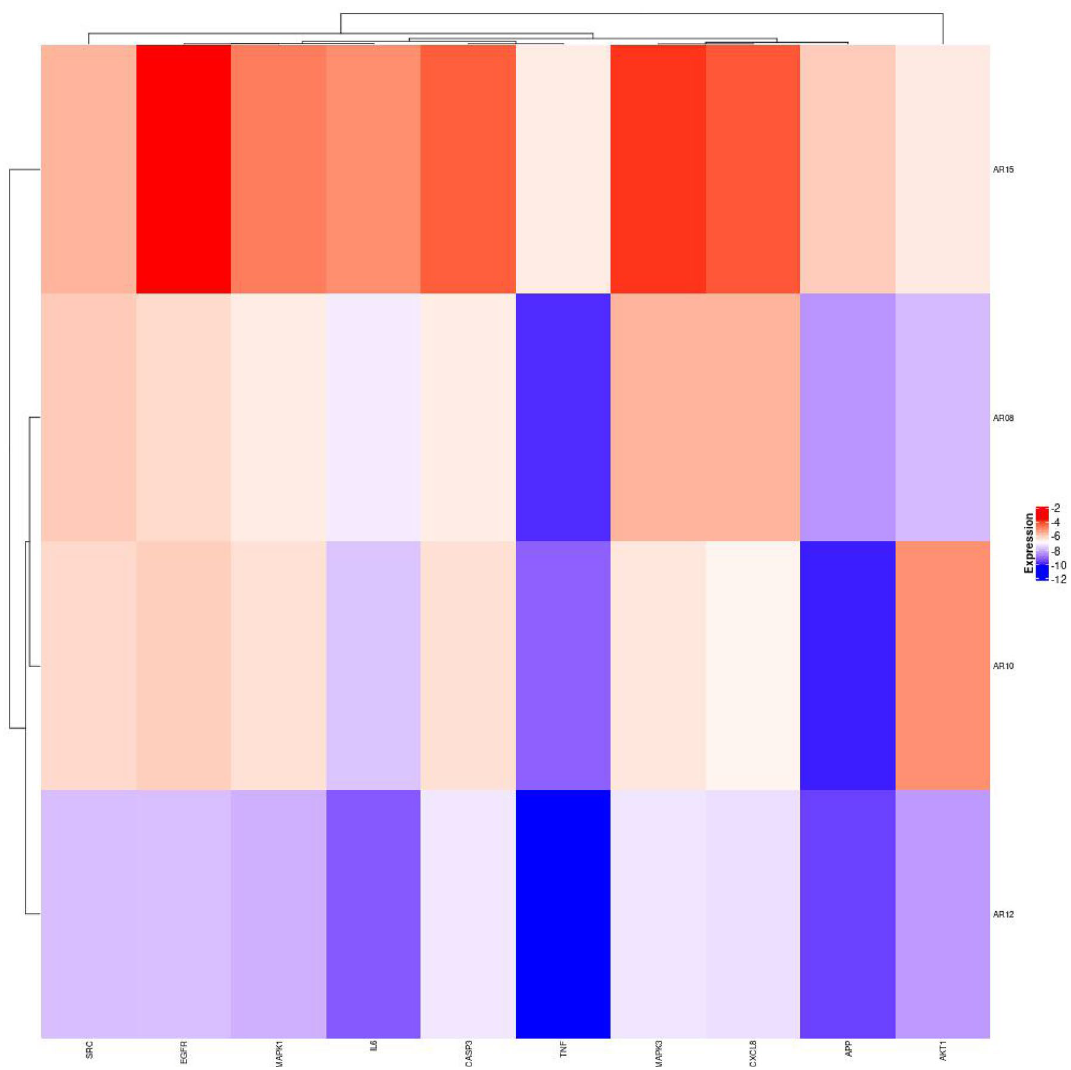
Figure 7. Heatmap of binding affinity. The bluer the color is, the more stable the binding force. AR10 stands for cynaropicrin, AR08 stands for 2- [(2r, 4ar, 8as)-4a-methyl-8-methyl-decalin-2-yl] acrylic acid, AR12 stands for eremanthin, and AR15 stands for